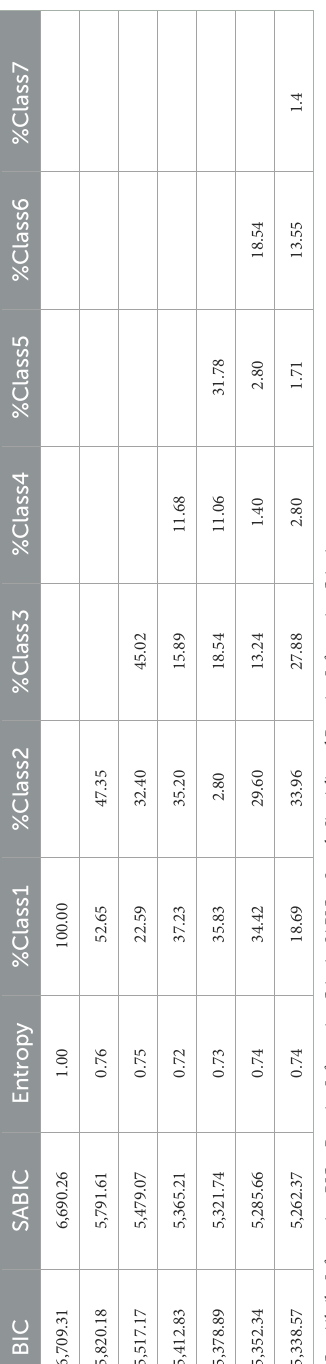
FIGURE2 Elbow plot of BIC values for model selection.